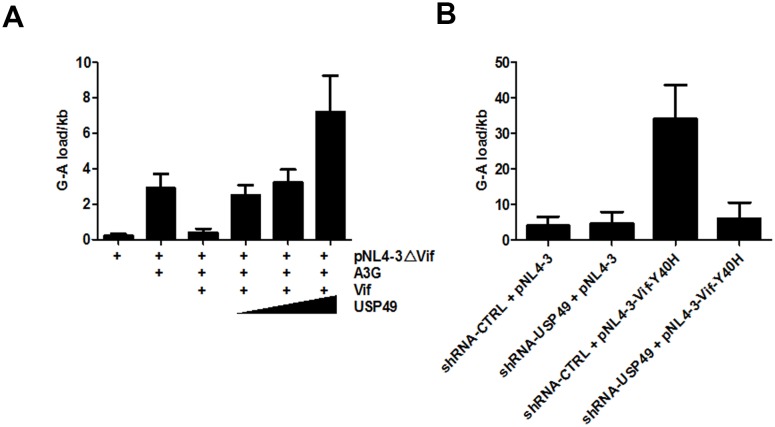
Analysis of A3G-induced hypermutation of prot DNA region.(A) G-to-A mutation loads in proviral DNA from viruses originally produced in Figure 2B (mean + /- SD of 3 independent experiments with a minimum of 10 sequences analyzed per condition). (B) G-to-A mutation loads in proviral DNA from viruses originally produced in Figure 2F (mean + /- SD of 3 independent experiments with a minimum of 10 sequences analyzed per condition).